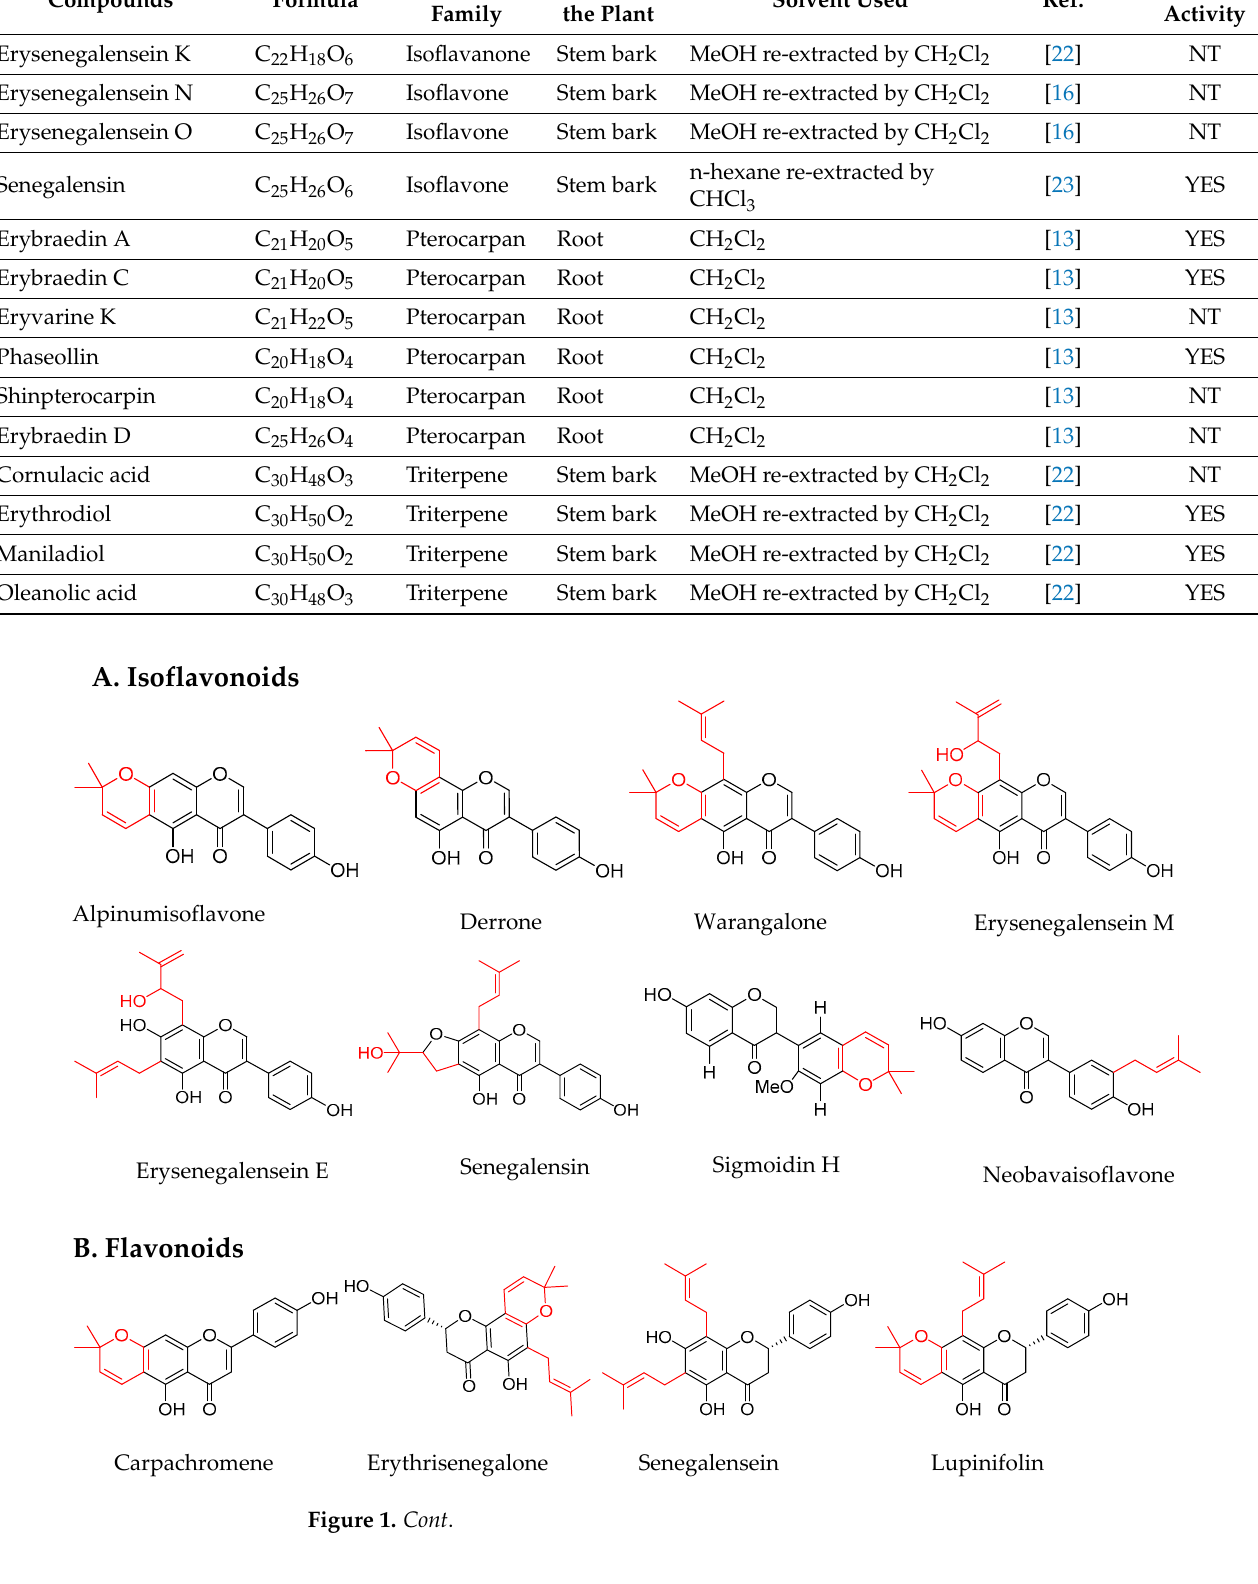
D. Triterpens Figure 1: Chemical structures of potential anticancerous compounds isolated from E. senegalensis. Flavonoids and isoflavonoids are all prenyled and the prenyl group is highlighted in red. The first 4 isoflavonoids are dimethylpyrano- isoflavonoids